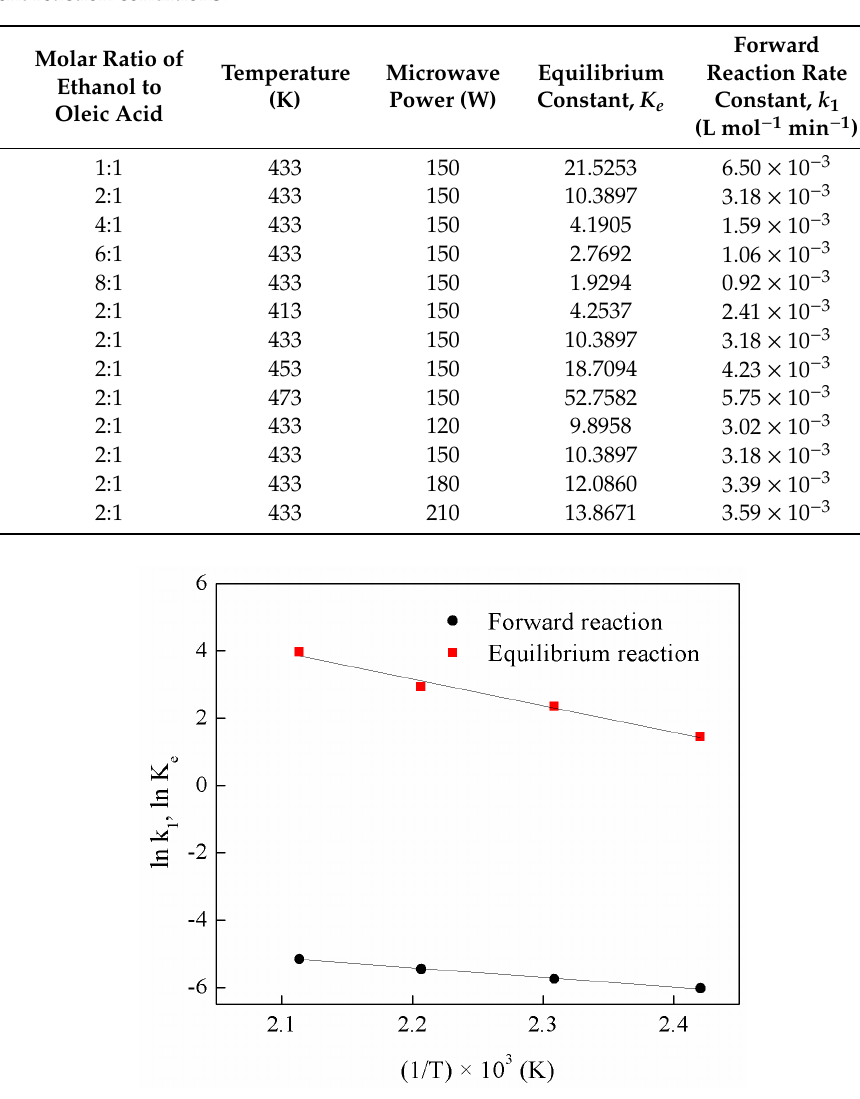
Table 1. Forward reaction rate constant k 1 and equilibrium rate constant K e for esterification under di ff erent reaction conditions.